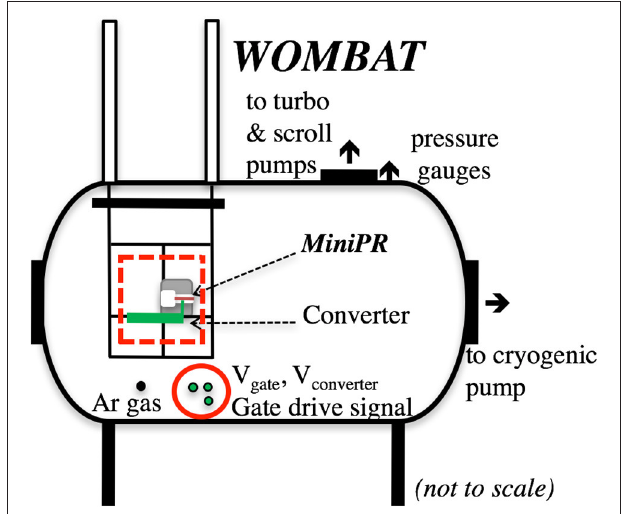
FIGURE 2 | Schematic of the WOMBAT vacuum chamber showing the MiniPR thruster and Converter assembly (dotted red line square shown in Figure 1A ).